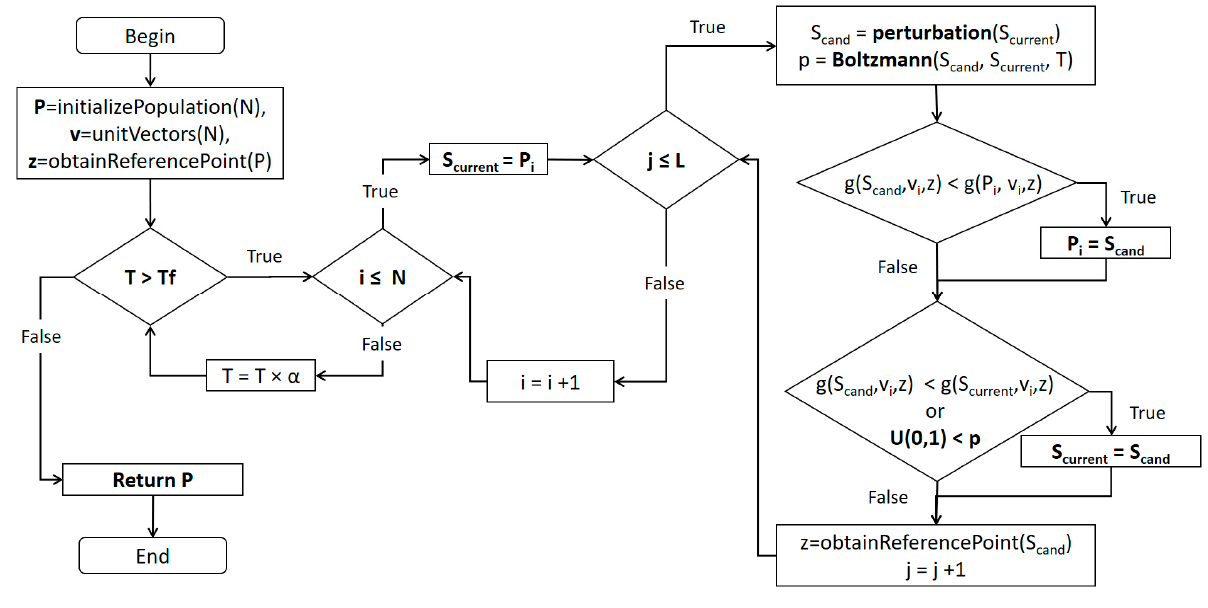
Figure 2. MOSA/D framework flowchart.